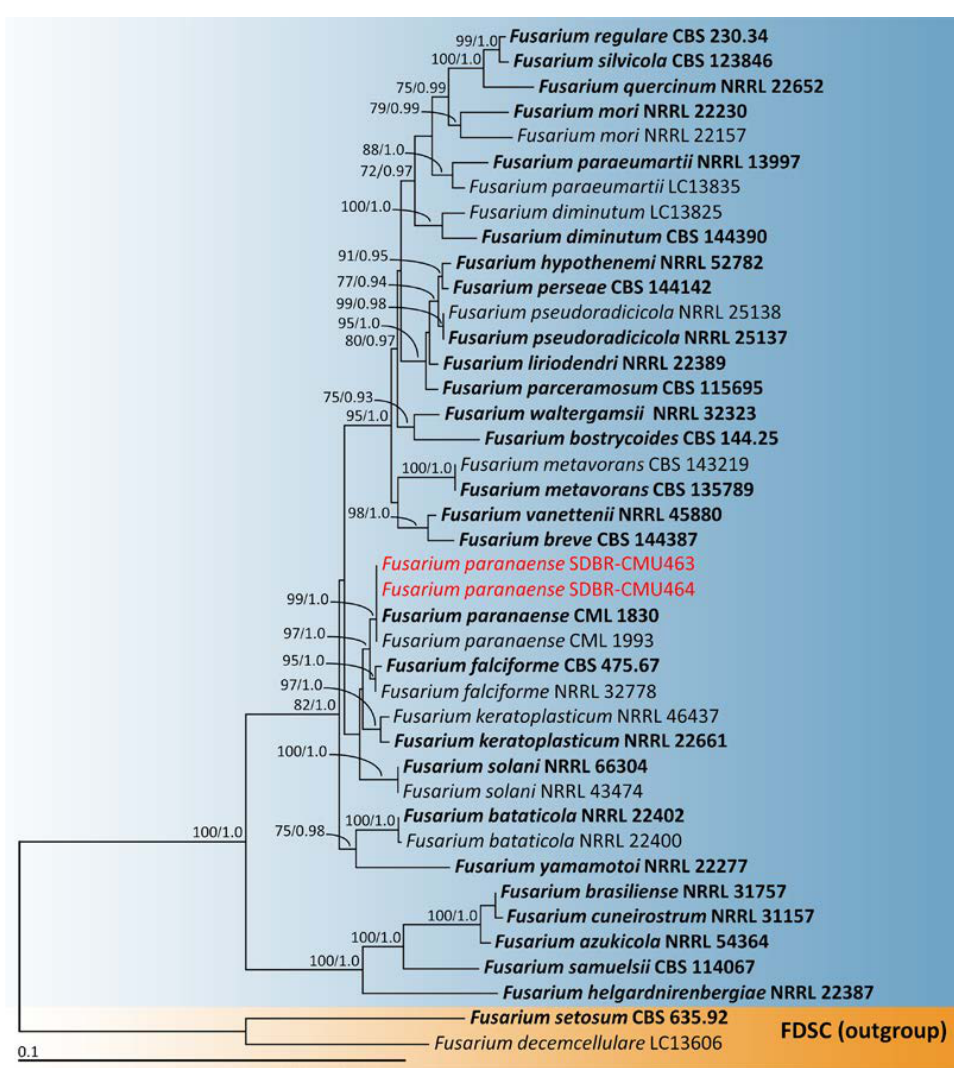
Figure 3. Phylogenetic tree derived from maximum likelihood analysis of Fusarium solani species complex of the combined tef-1 and rpb2 sequences of 41 taxa. The outgroup included F. decemcellulare LC13606 and F. setosum CBS 635.92. Numbers above branches are the bootstrap percentages (left) and Bayesian posterior probabilities (right). Branches with bootstrap and Bayesian posterior probabilities values greater than or equal to 75% and 0.95, respectively, are shown at each branch. The scale bar displays the expected number of nucleotide substitutions per site. The sequences of the fungal species derived in this study are shown in red. Type species are shown in bold.